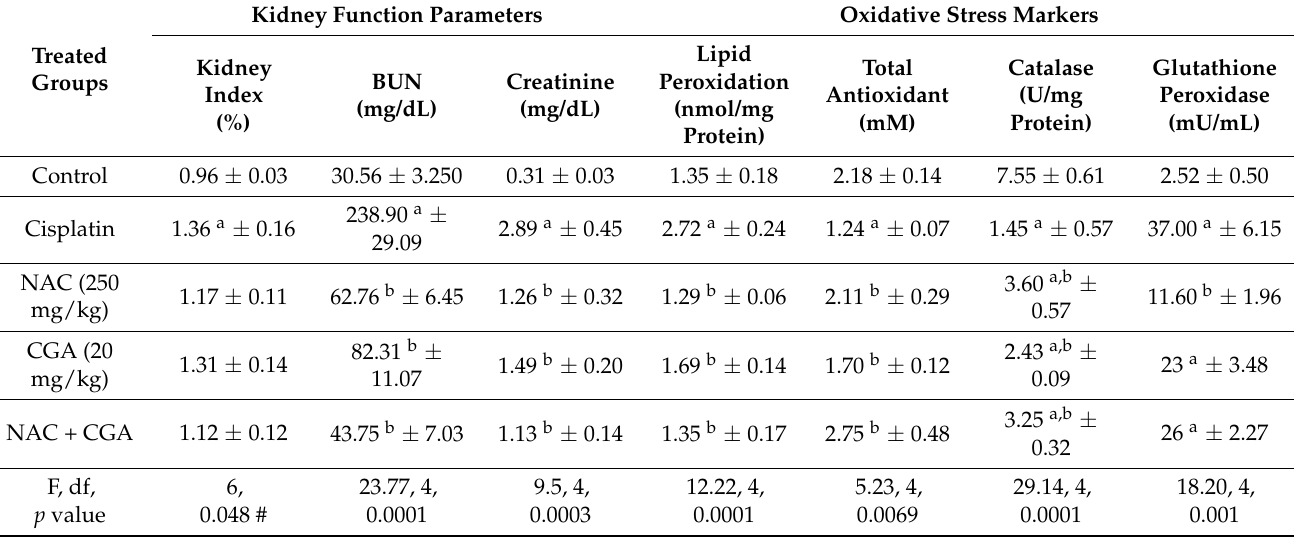
Table 1. Effect of NAC and/or CGA on Cisplatin-Induced Changes in Renal Function Indices and Oxidative